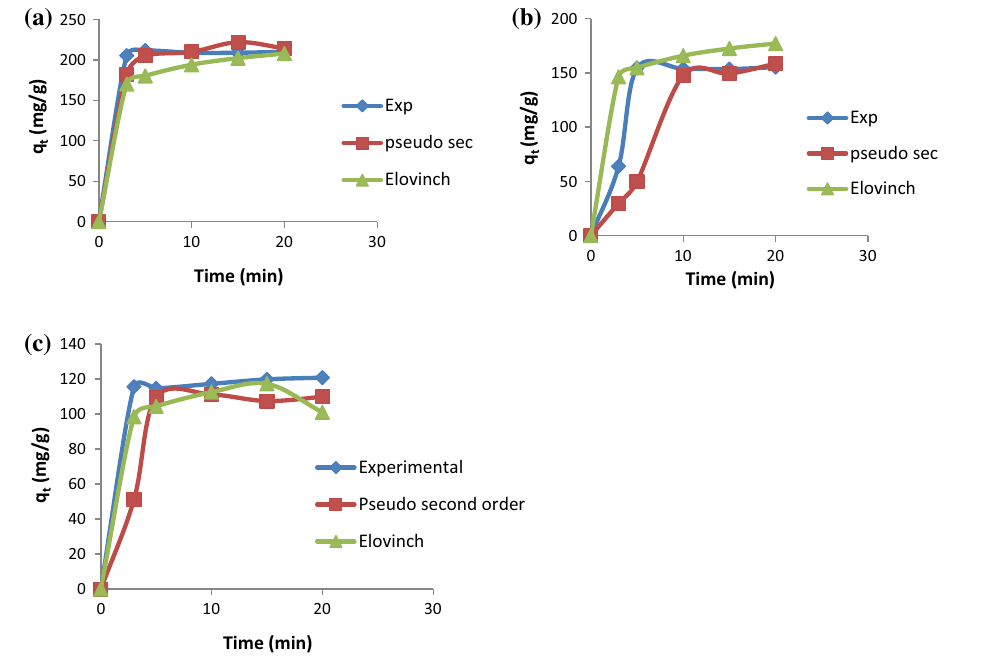
Fig. 10 Nonlinear kinetic plots at selected coagulant dosages a 1 g/L, b 3 g/L and c 5 g/L